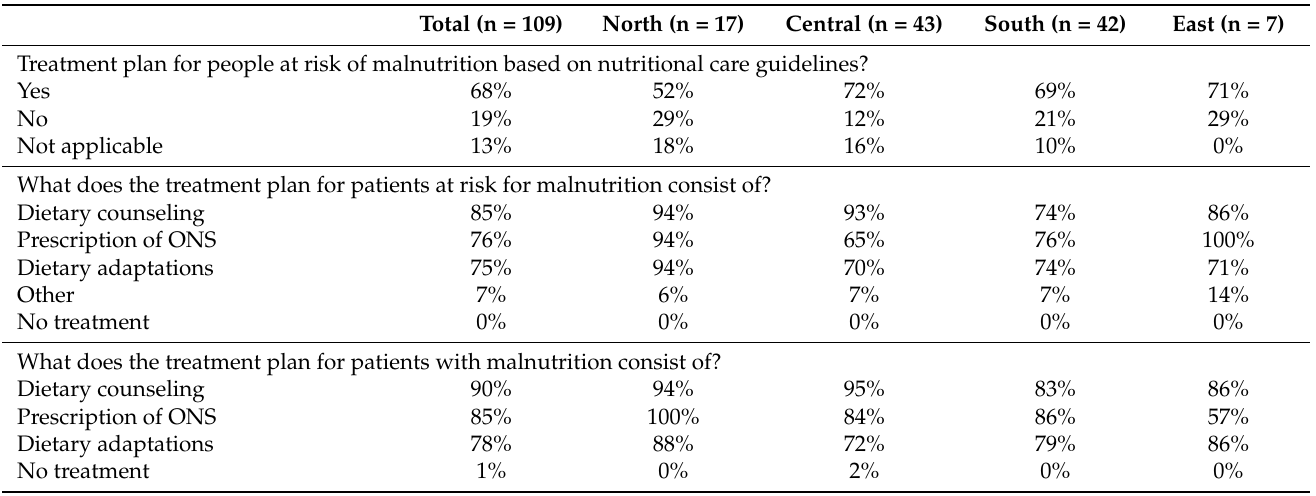
Table 4. Treating people with (risk of) malnutrition.